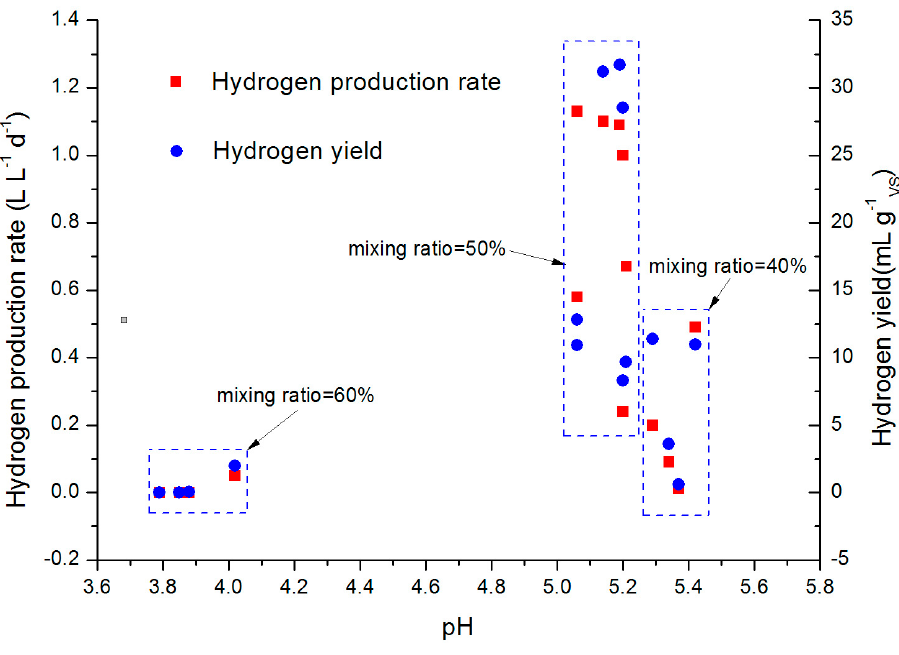
Figure 3. Hydrogen production vs. pH.